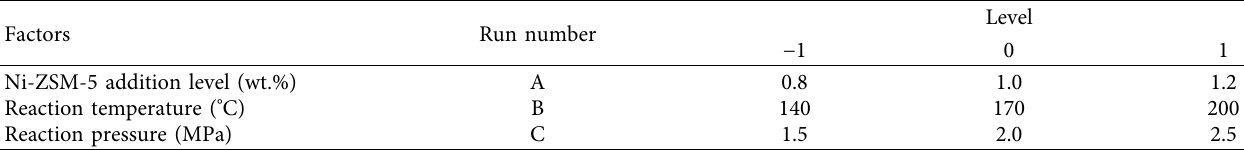
Figure 1: Process diagram of the catalytic hydrogenation unit.1. High-pressure reactor; 2. no power booster; 3. hydrogen source; 4. nitrogen source; 5. controller; and 6. liquid collector. Table 1: Box–Behnken experimental factor level.